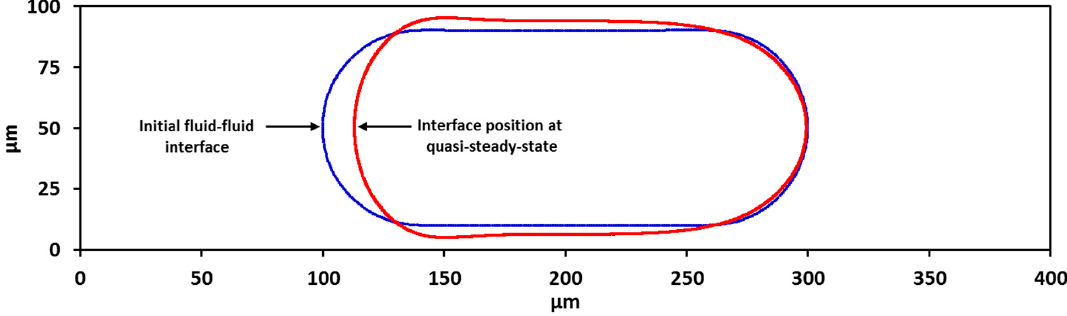
Figure 5. Position of fluid–fluid interface at quasi-steady-state versus its position at initial condition.